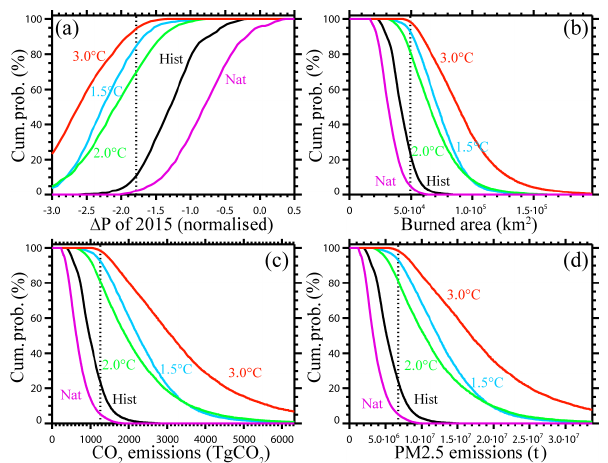
Figure 6. Changes in the cumulative probability functions. (a) The vertical axis indicates the probability (%) of (cid:49)P being lower than a given horizontal value (no unit). Solid lines denote the 50% values of the 1000 random samples of the Nat (purple), Hist (black), 1.5 ◦ C (light blue), 2.0 ◦ C (green) and 3.0 ◦ C (red) ensembles. The verti- cal dotted line is the observed 2015 value. The other panels show the probabilities of exceeding the given horizontal values for (b) the burned area (km 2 ), (c) CO 2 emissions (TgCO 2 ) and (d) PM 2 . 5 emissions (t).